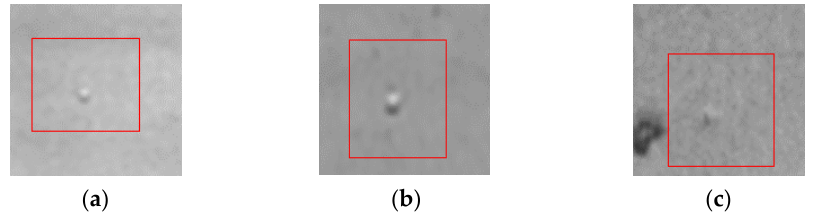
Figure 3. Pit defects according to the difficulty of observability; ( a ) strong level, ( b ) medium level, ( c ) weak level.